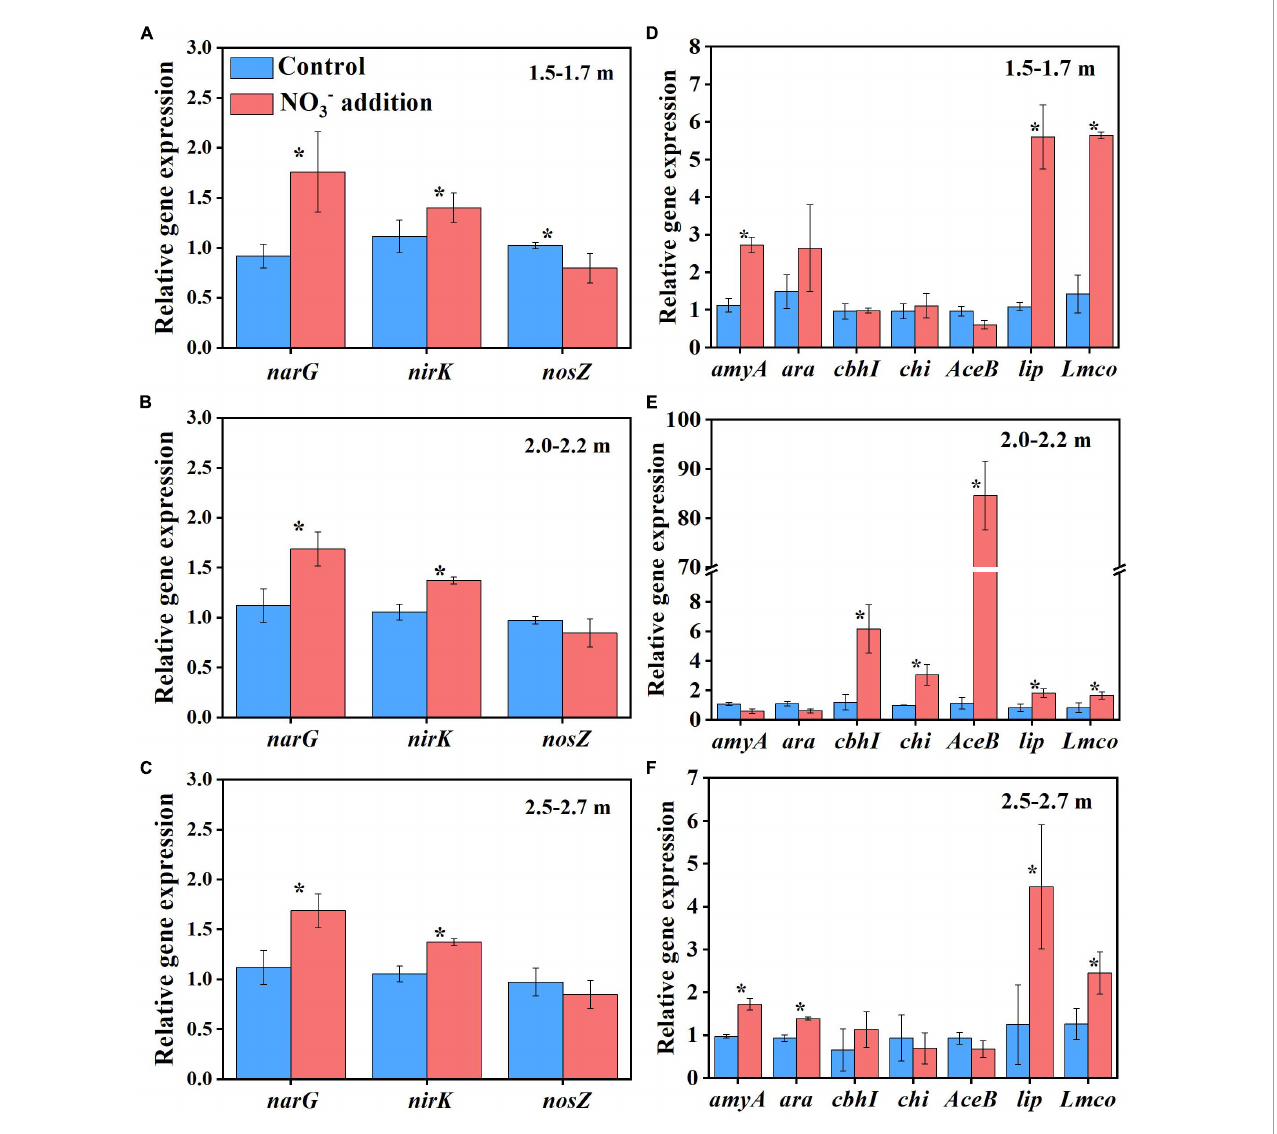
FIGURE5 Nitrate addition effects on the relative gene abundances of denitrification genes ( narG , nirK , and nosZ ) and key and recognized C degradation genes ( amyA , arA , cbhI , chi , AceB , lip , and Lmco ) in deep soil depths of 1.5–1.7 m (A,D) , 2.0–2.2 m (B,E) , and 2.5–2.7 m (C,F) after 55 days at the end of Experiment 1. Data are shown as the mean ± standard deviations ( n = 3). Asterisk denotes significant difference ( P < 0.05) between the two